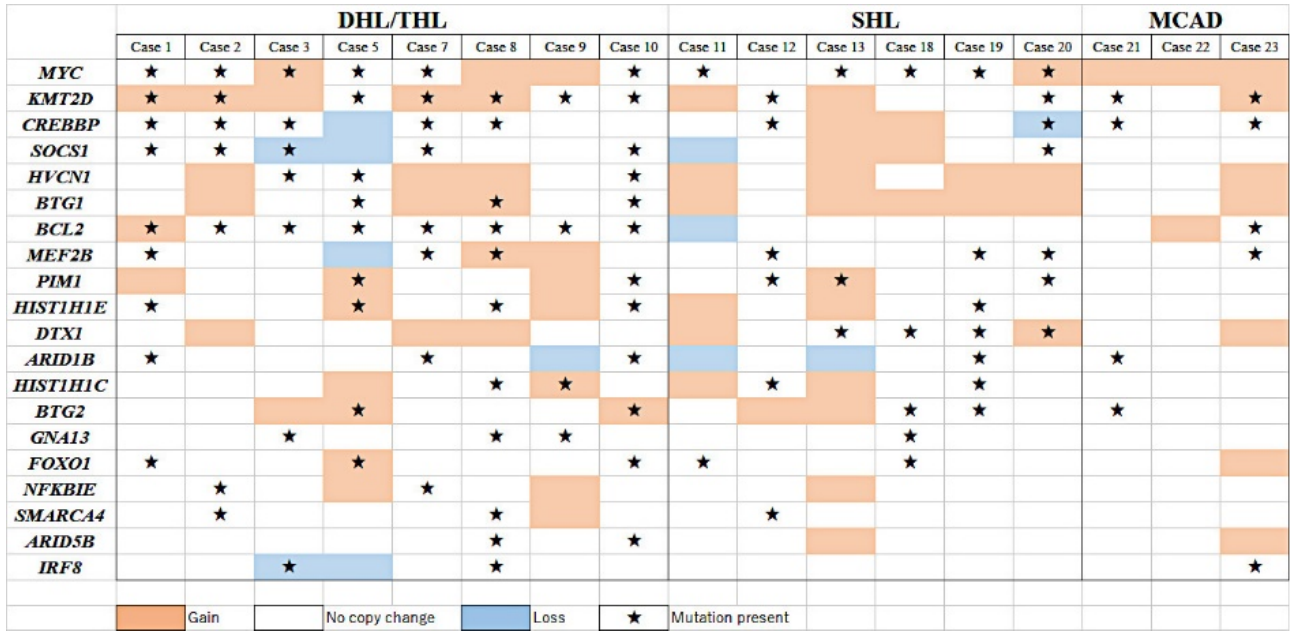
Figure 3. Combined copy number alterations and mutational profile.